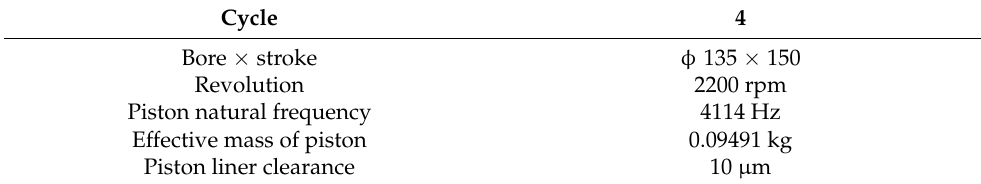
Figure 2. Dynamic characteristics of the piston. ( a ) Measured frequency response of the piston; ( b ) first elastic mode of the piston. Table 1. Calculation conditions of piston slap analysis.